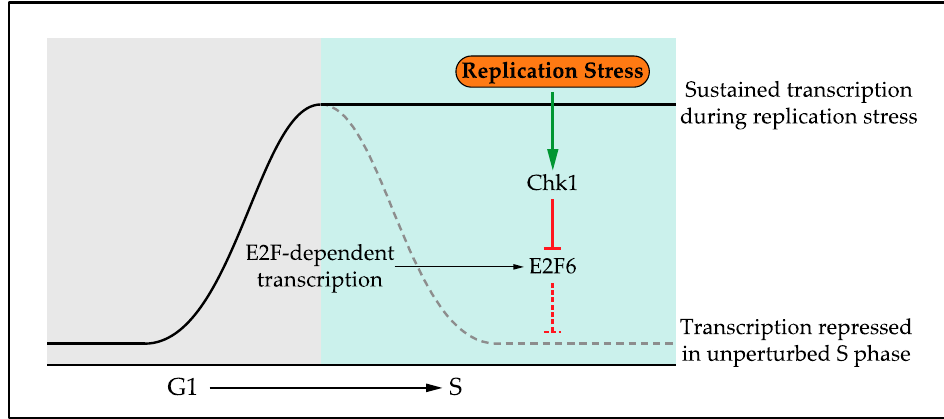
Figure 2. In the response to DNA replication stress the checkpoint effector kinase inactivates a repressor, resulting in sustained G1/S cell cycle transcription. This transcriptional response has a key role in the tolerance to DNA replication stress. This response is conserved from yeast to man, with the mammalian names shown here.